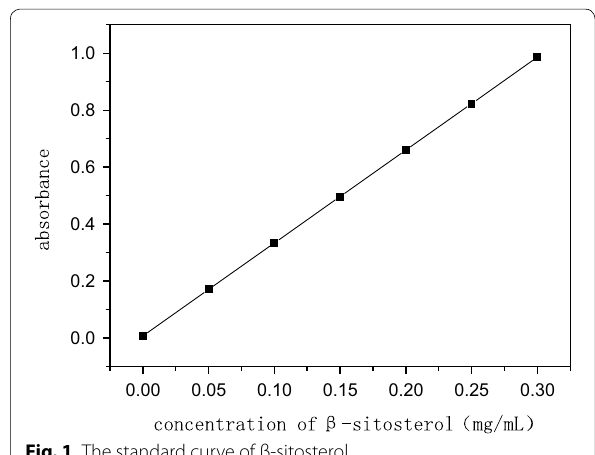
Fig. 1 The standard curve of β-sitosterol